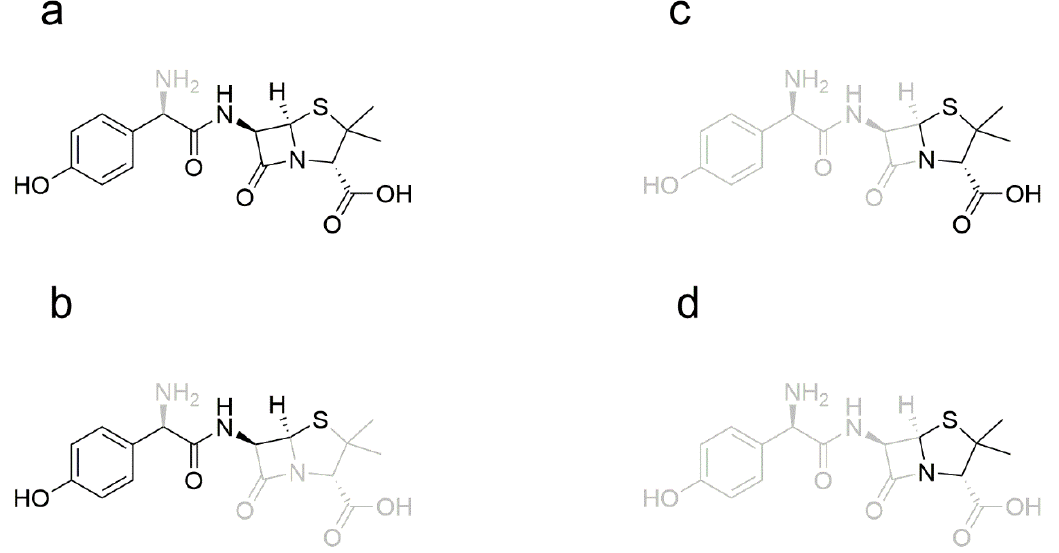
Figure 13. Possible structures of fragment ions in amoxicillin. ( a ) Possible structure of the m / z 349 fragment ion; ( b ) Possible structure of the m / z 208 fragment ion; ( c ) Possible structure of the m / z 160 fragment ion; ( d ) Possible structure of the m / z 114 fragment ion.